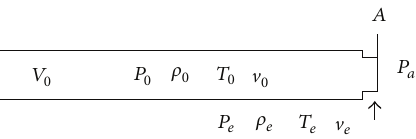
Figure 4: The equivalent structure of third stage.